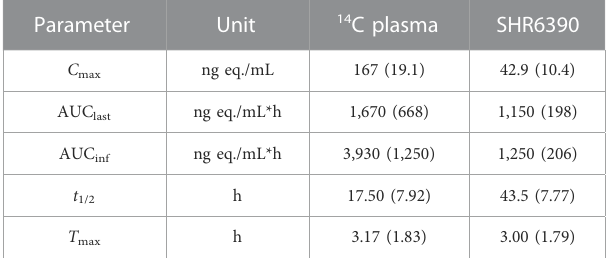
TABLE 2 Pharmacokinetic parameters of total radioactivity and SHR6390 in plasma after a single oral administration of [ 14 C]SHR6390 to healthy volunteers [mean